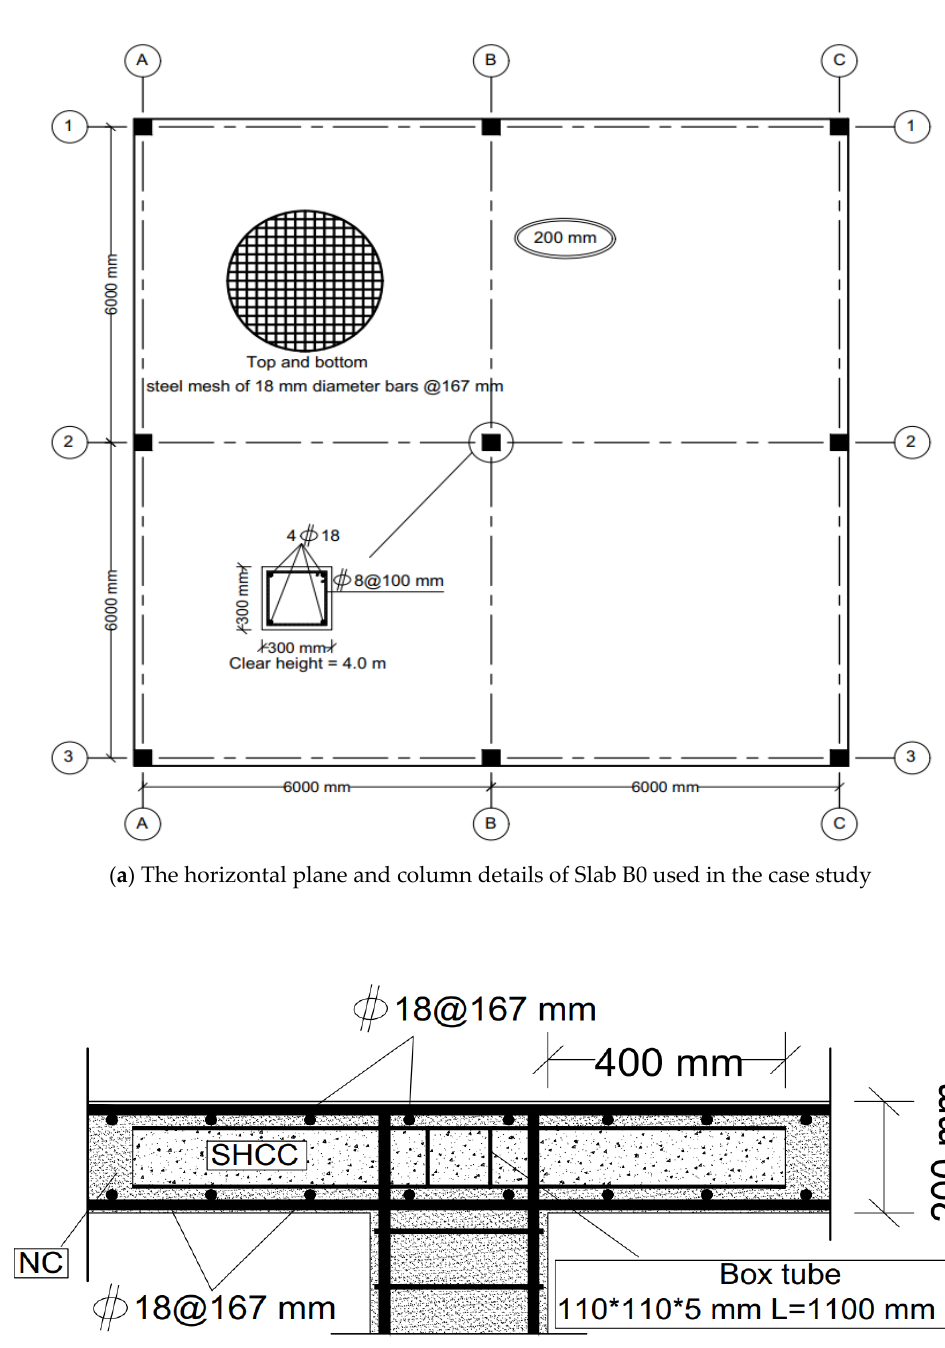
Figure 25. Details of the slabs used in the case study.